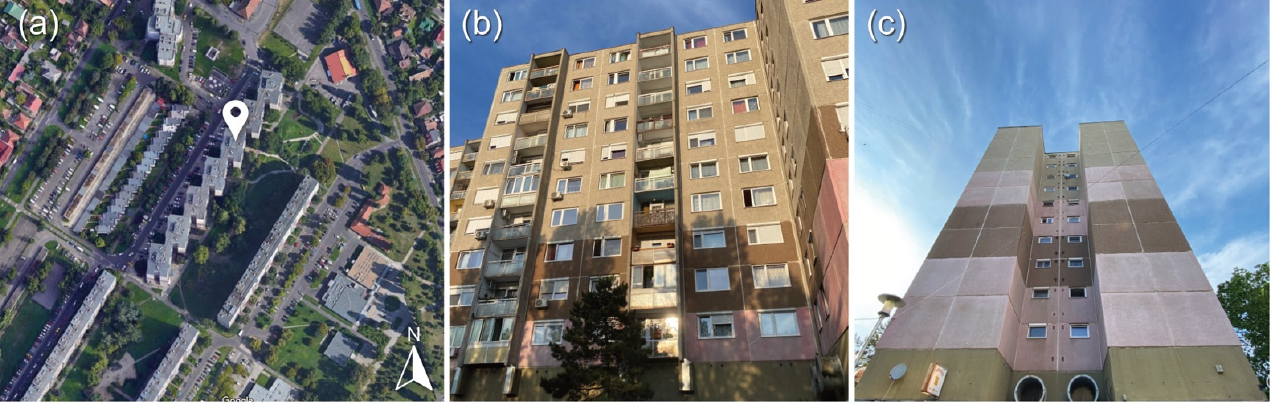
Figure 1. ( a ) Location of the building (source: Google Maps); ( b ) west façade of the building; ( c ) south façade of the building.